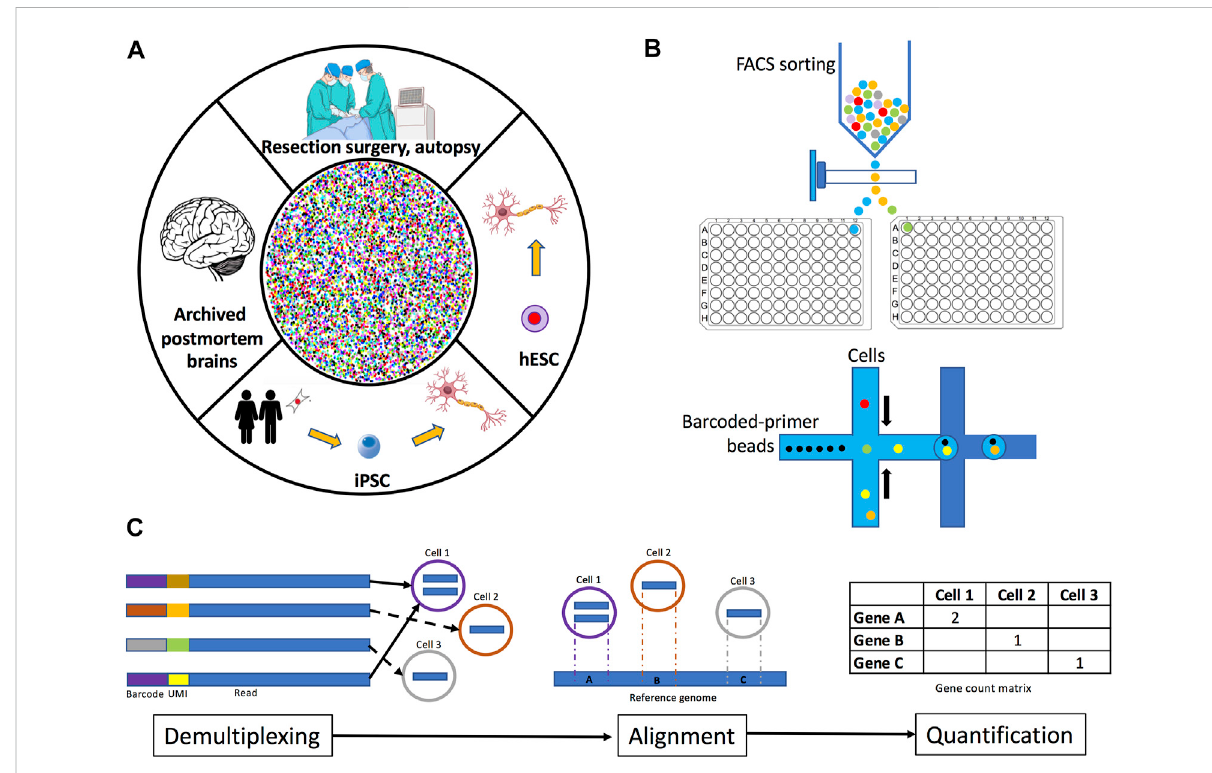
FIGURE 1 Overview of human brain single-cell and single-nuclei experimental methodology. (A) Tissue for isolating single-cells or single-nuclei may be obtained fresh from resection surgeries or autopsies, archived from frozen or formalin- fi xed paraf fi n-embedded postmortem brains, or from neuronal cell cultures differentiated from iPSC or embryonic stem cells. (B) Plate-based and droplet-based single-cell and single-nuclei separation methods. (C) Data preprocessing methods include demultiplexing, read alignment, and quanti fi cation. Demultiplexing consists of the identi fi cation and removal of barcodes from sequencing reads. Read alignment is the process of mapping reads to a reference genome and/or transcriptome. Quanti fi cation involves the determination of the number of read counts per gene for each cell identi fi